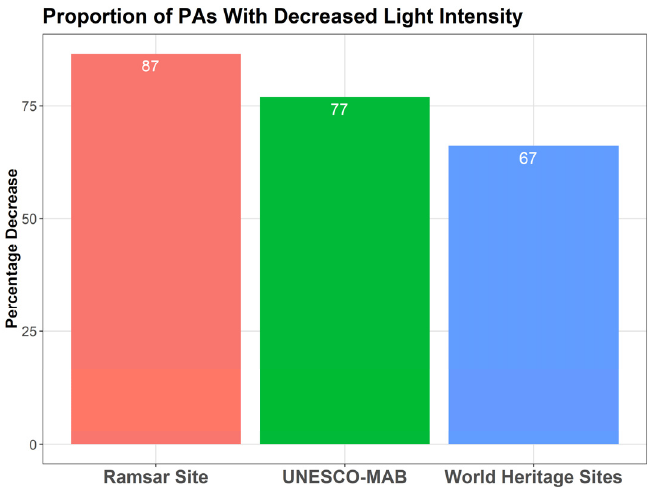
Figure 6. The proportion of PAs with decreased light intensity across international designations.